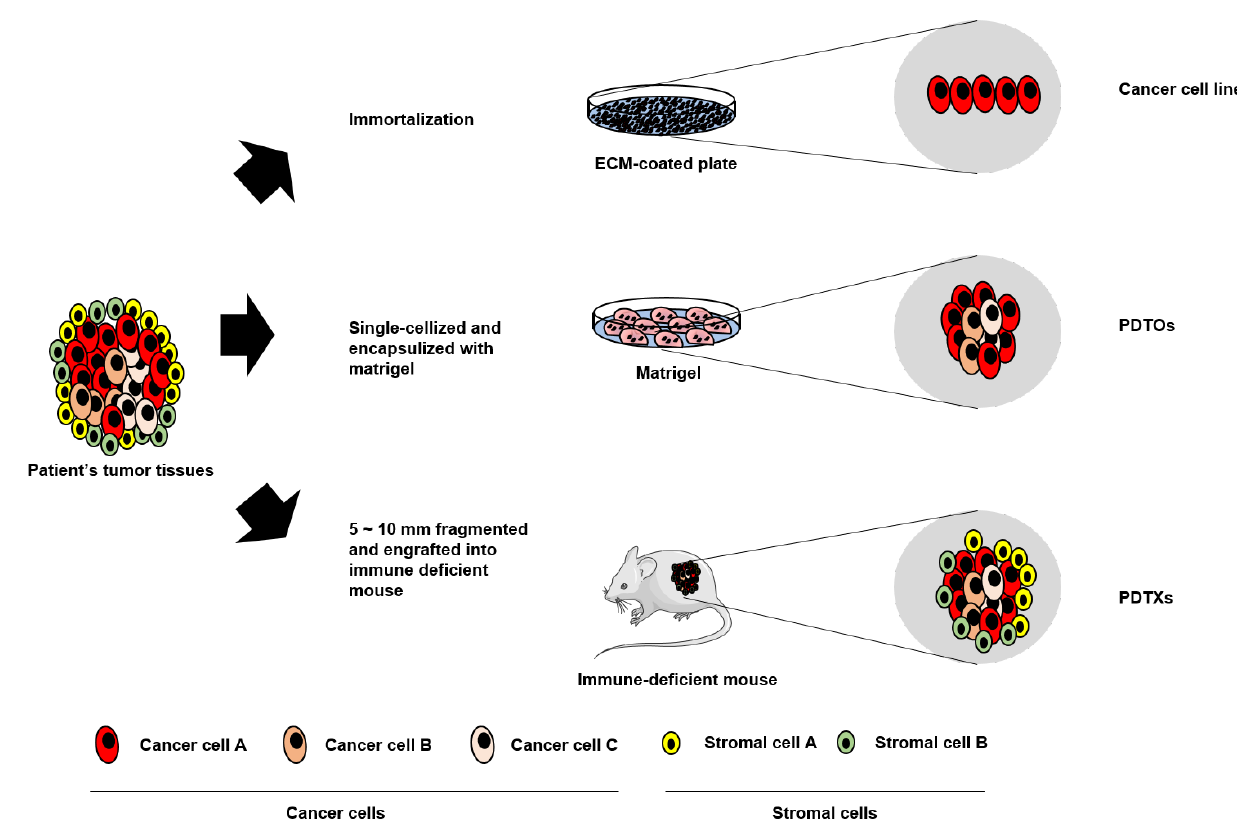
Figure 3. Establishment of cancer cell lines, PDTOs, and PDTXs.